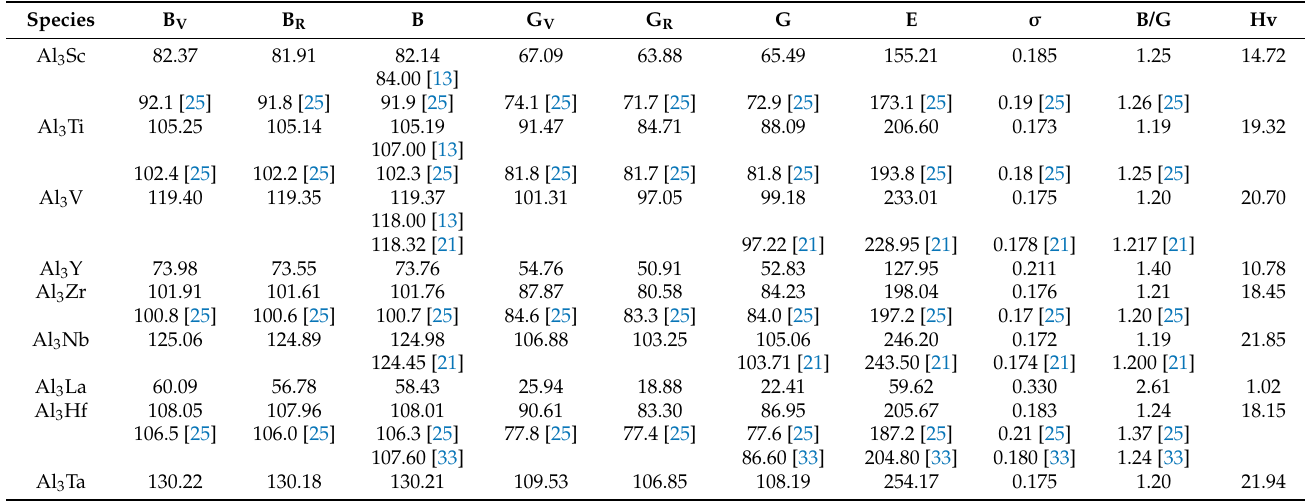
minimum of elastic modulus. The Hill approximation uses the average value of Voigt and Reuss to express the elastic constants of materials. Table 3. The calculated bulk modulus (GPa), shear modulus (GPa), Young’s modulus (GPa), B/G, Poisson’s ratio and Vickers hardness (GPa) of Al 3 TM compounds.